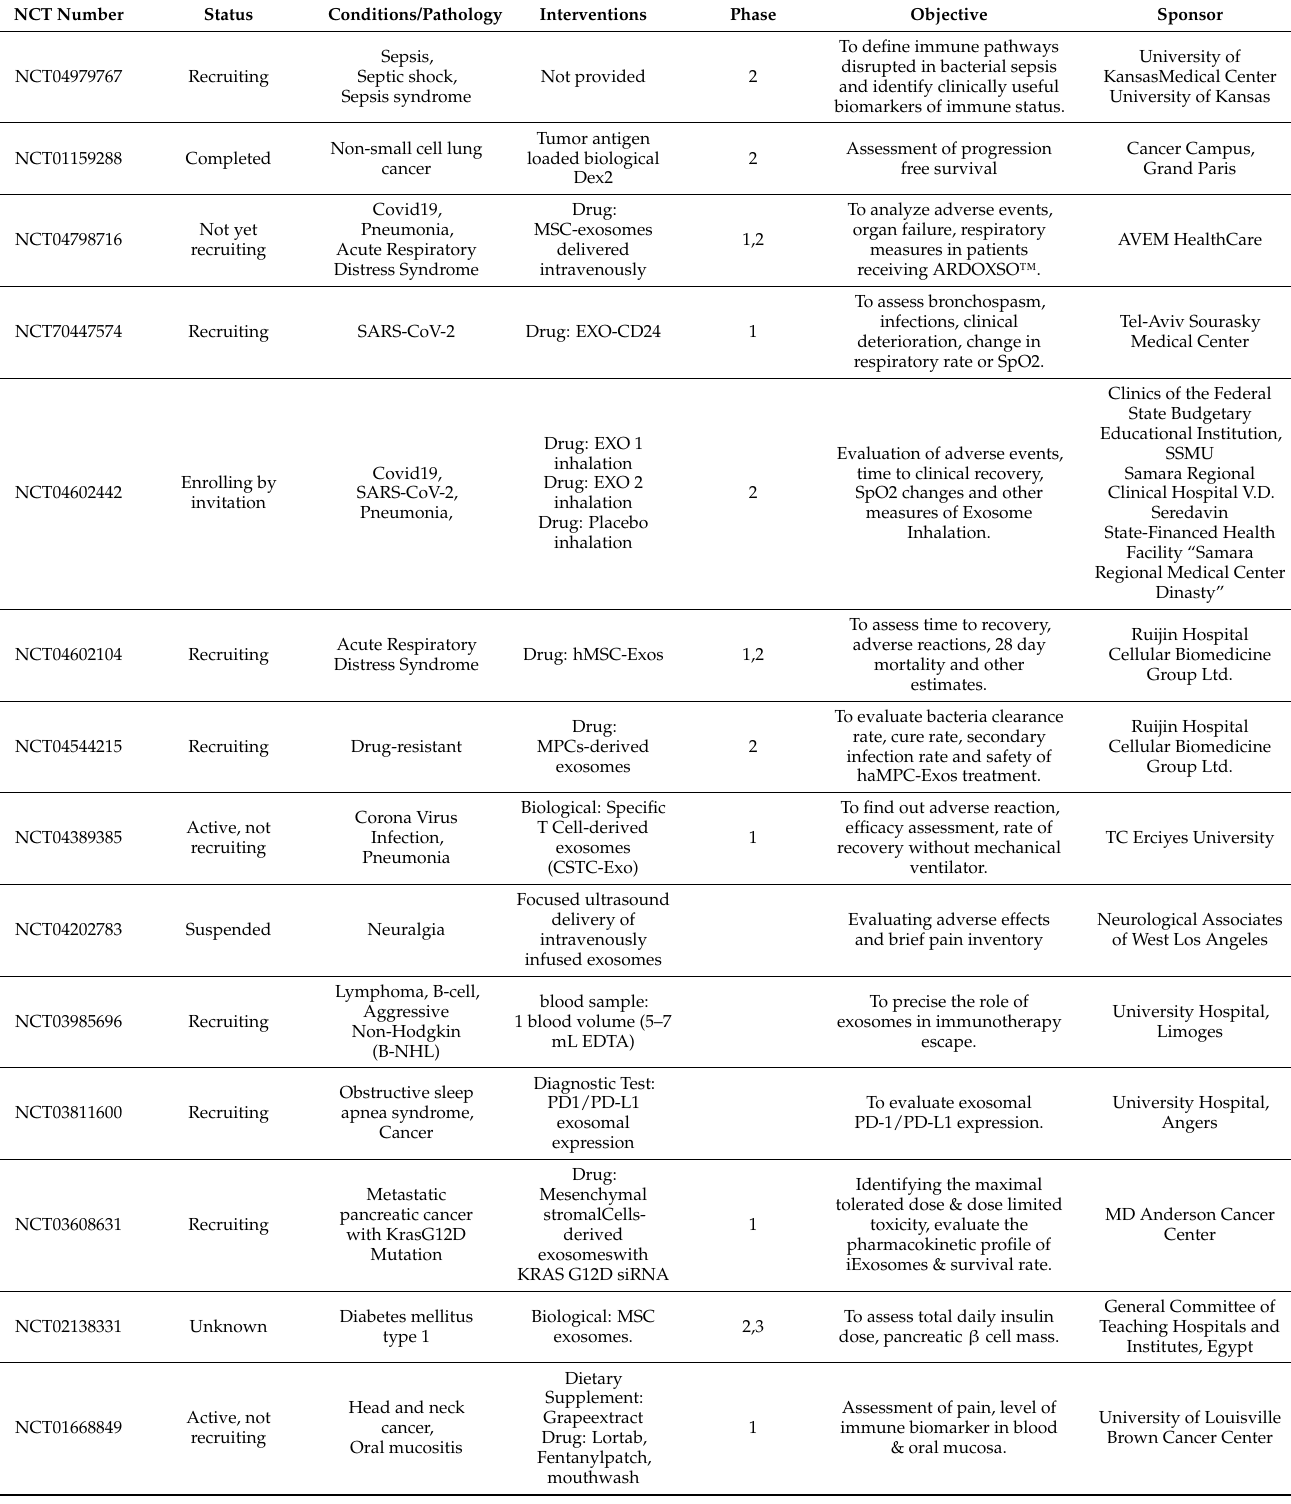
Table 4. Ongoing clinical trials of exosomes for